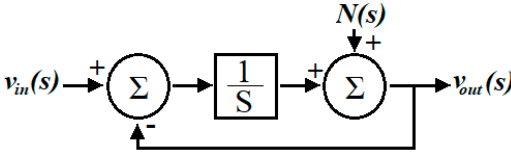
Figure 12. ΣΔ -ADC representation in the S domain.